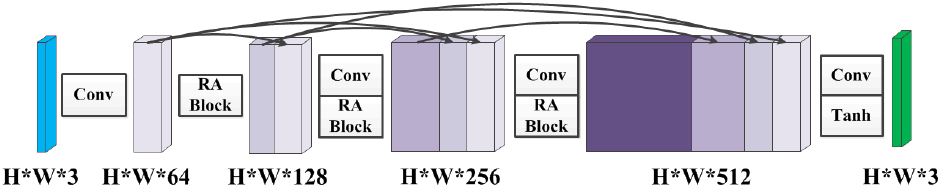
Figure 2. The densely connected structure as the generator. Each “Conv” contains sequence Conv- BN-ReLU, “Tanh” contains sequence Conv-Tanh, and “RA Block” refers to the residual spatial and channel attention module. “Conv” denotes the convolution, “BN” denotes the batch normalization, “ReLU” denotes the rectified linear unit, and “Tanh” denotes an hyperbolic tangent function. The kernel size of each convolution operation is 3 × 3, the stride is 1 × 1, and the padding is 1 × 1. The input and output channel numbers can be obtained according to the parameters in the